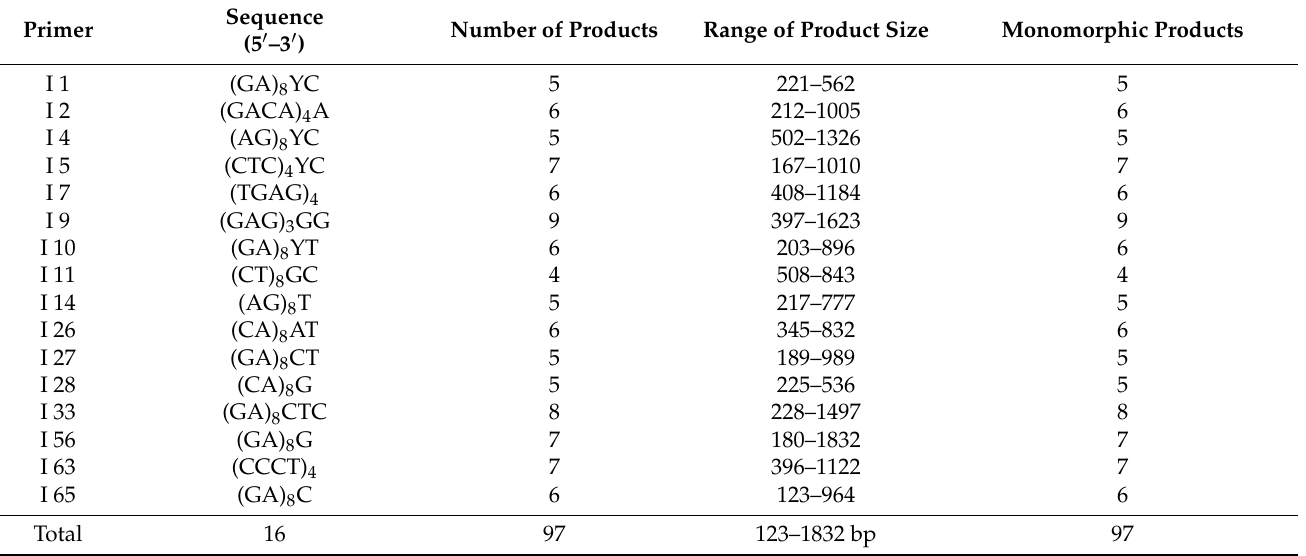
Table 3. Qualities of the ISSR primers applied in the molecular